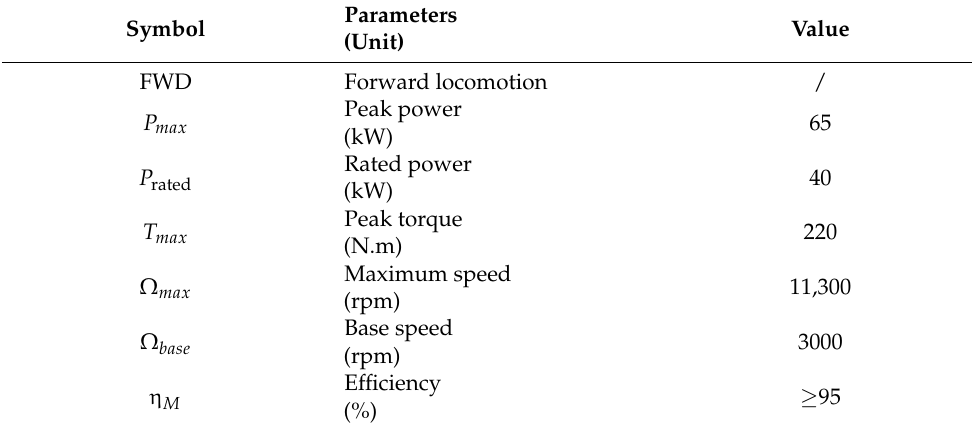
Table 2. Characteristics of the Q90 motor.